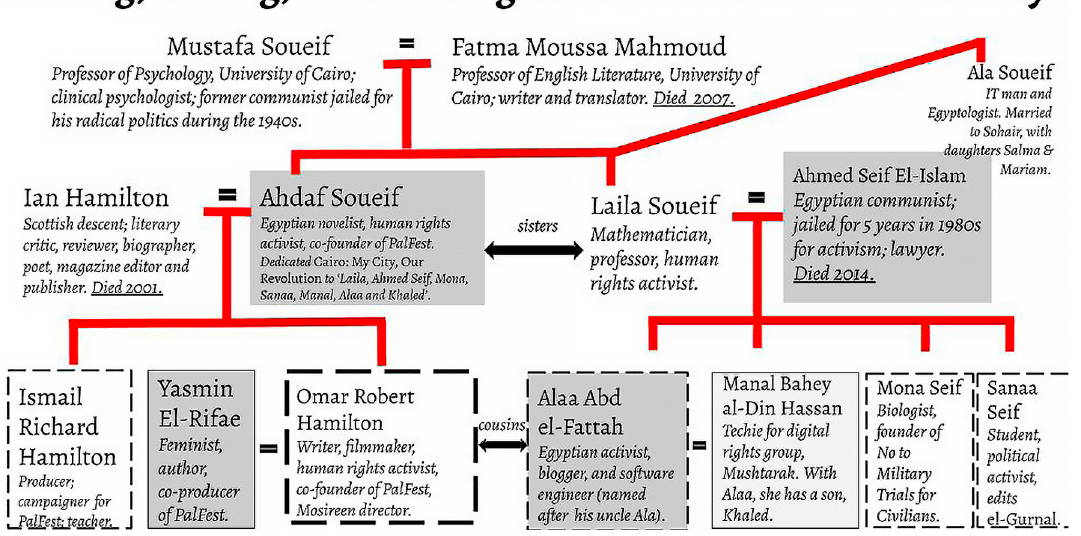
Figure 1. Family Tree by Freya Hope and Claire Chambers.